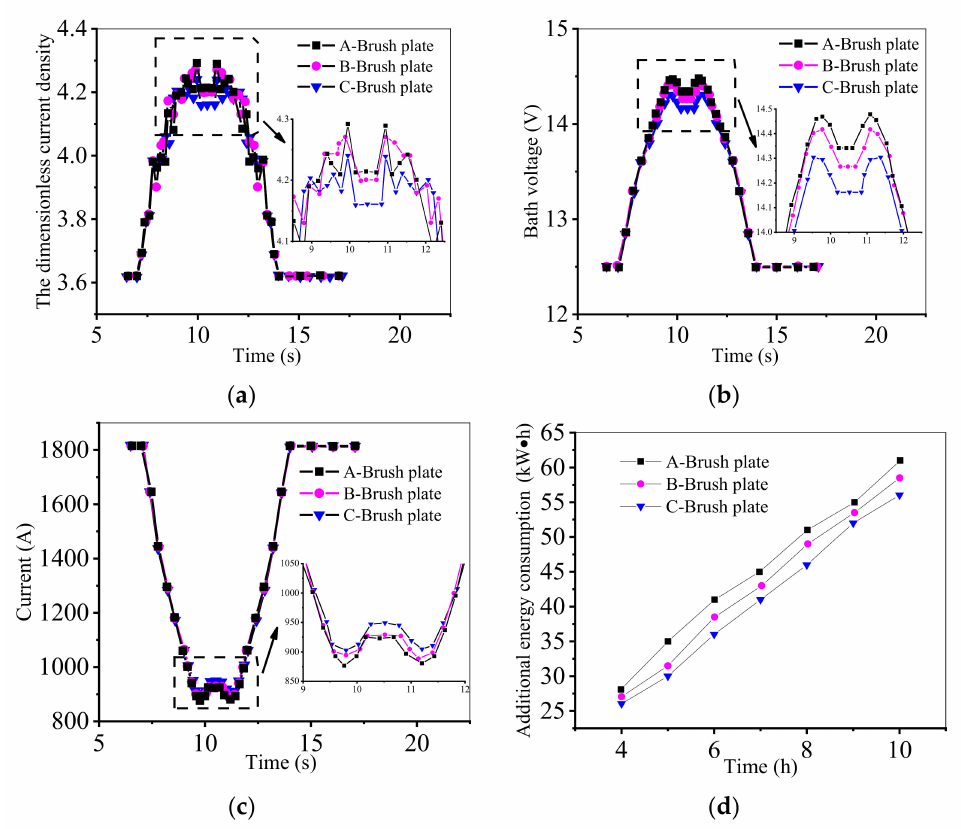
Figure 17. The variation of parameters with time. ( a ) The dimensionless current density; ( b ) Bath voltage; ( c ) Current; ( d ) Additional energy